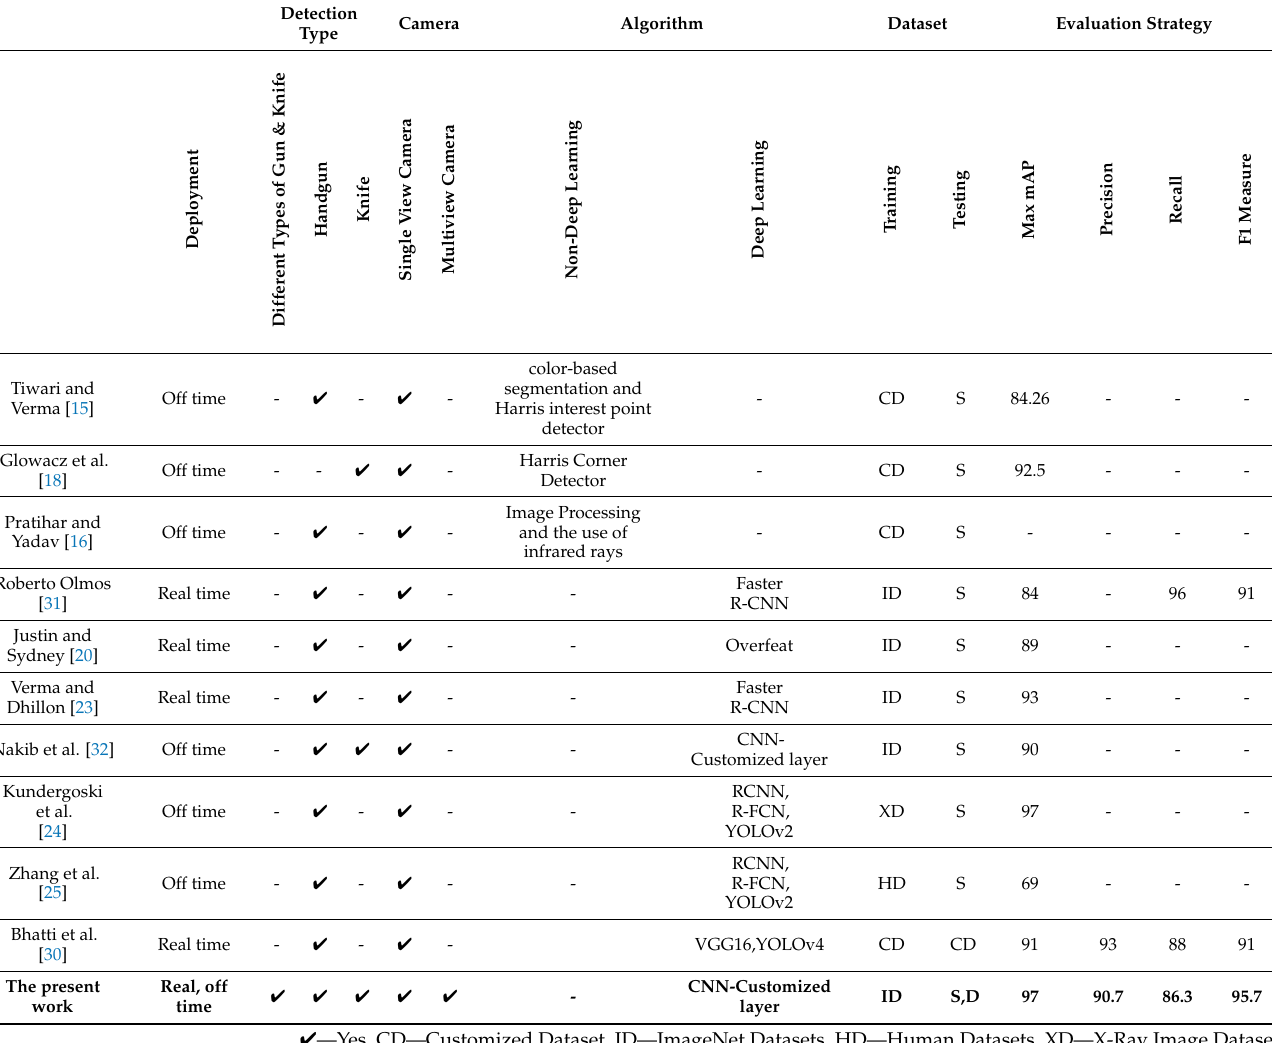
Detection Type Camera Algorithm Dataset Evaluation